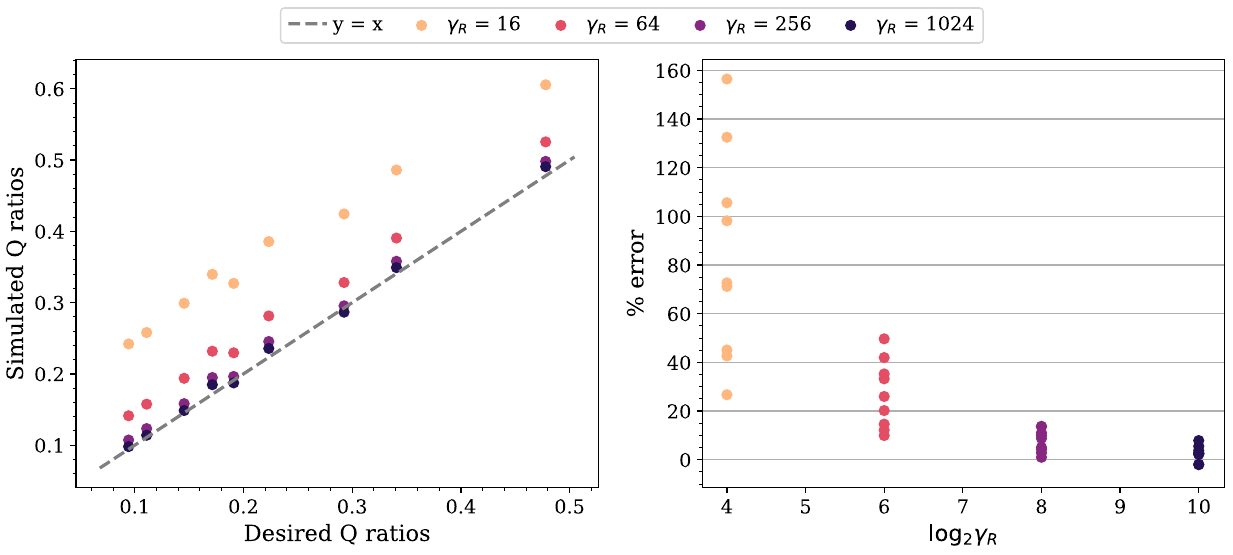
Figure 8. Comparison between the simulated and the desired flow rate ( Q ) ratios as γ R varies for a fixed γ RC /γ R . The results are obtained from the simulations on the coarse grid of the profunda femoris domain using γ RC /γ R 64 . The outlet 5 was arbitrarily selected as the reference when computing these ratios. We observe = that the percentage error of the Q ratios reduces exponentially as γ R increases; when log 2 γ R all the outlets are within